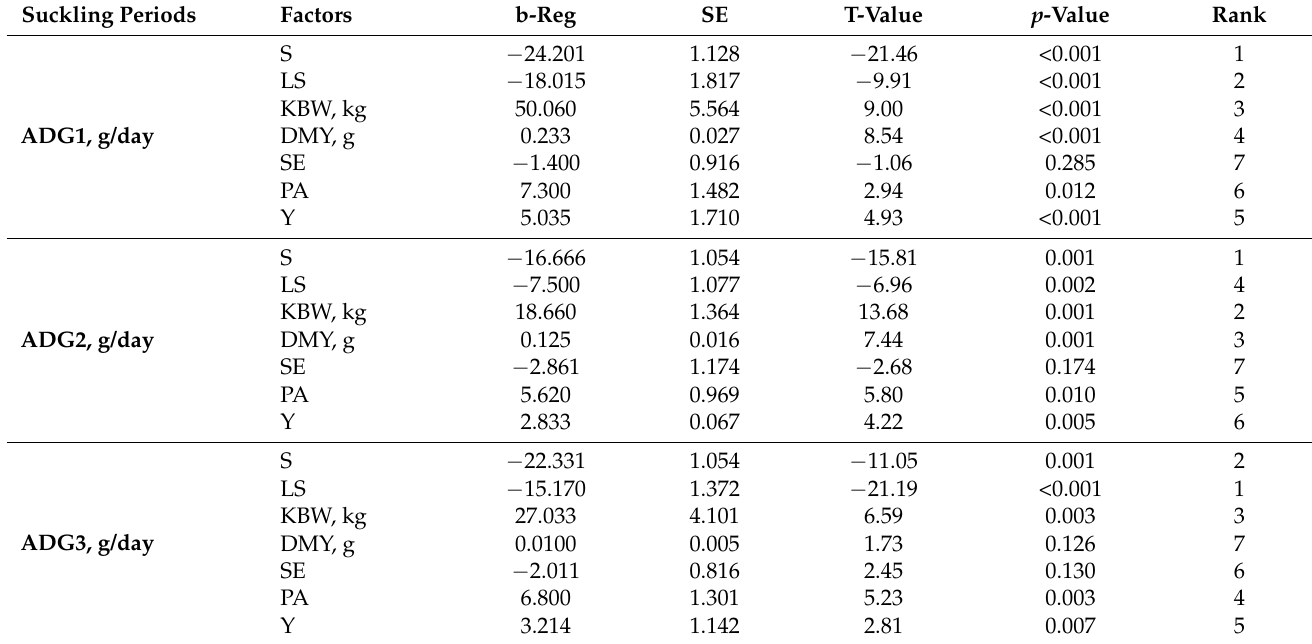
Table 2. Multiple linear regression analysis of ADG on maternal, postnatal, and management-related factors during suckling periods of Zaraibi goat